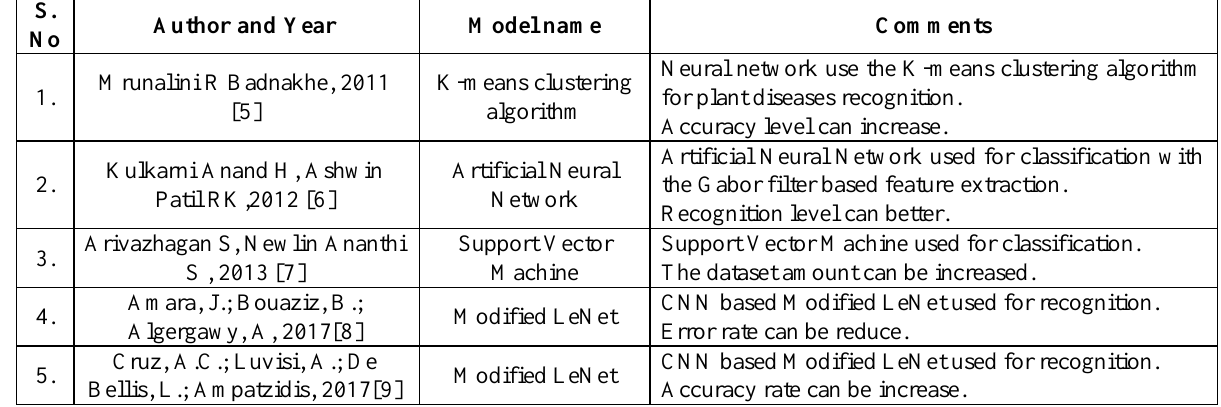
Table 1: Existing research related to plant diseases recognition.